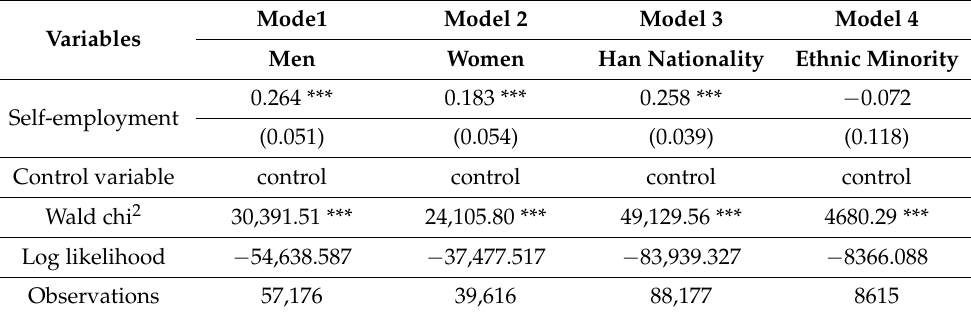
Table 7. Heterogeneous effects of self-employment on the likelihood of